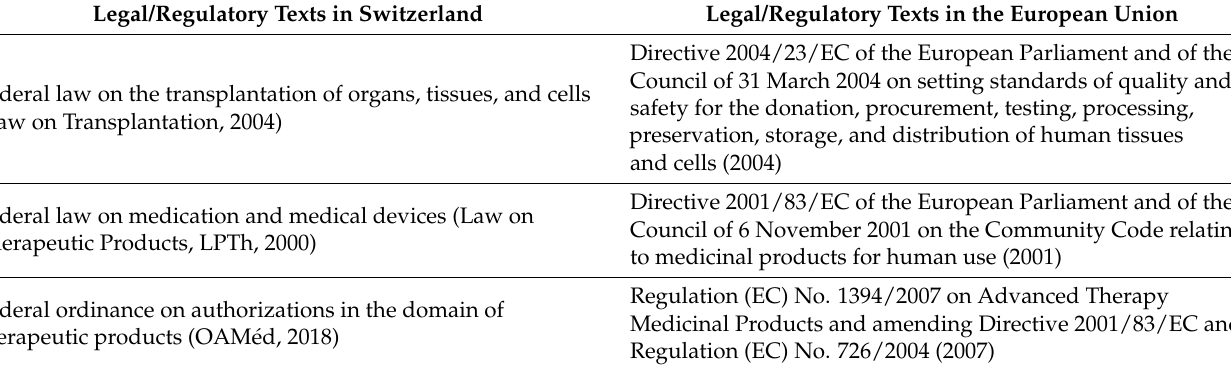
Table 2. Comparative overview of selected and notable applicable legal and regulatory framework documents covering the development and practices of autologous and allogeneic cell therapy in Switzerland and in the European Union. High similarity existed in definitions, requirements, and possibilities between both considered and neighboring jurisdictions. It was noteworthy that in several instances, the European documents were applicable in part by extension to Switzerland. Most aspects concerning specific technical requirements for cellular therapies in Switzerland were derived from international (e.g., ISO, ICH), European (e.g., EMA, EDQM), and American (e.g., FDA) official sources. EC, European Commission; EDQM, European Directorate for the Quality of Medicines and Healthcare; EMA, European Medicines Agency; FDA, US Food and Drug Administration; ICH, International Council for Harmonization; ISO, International Organization for